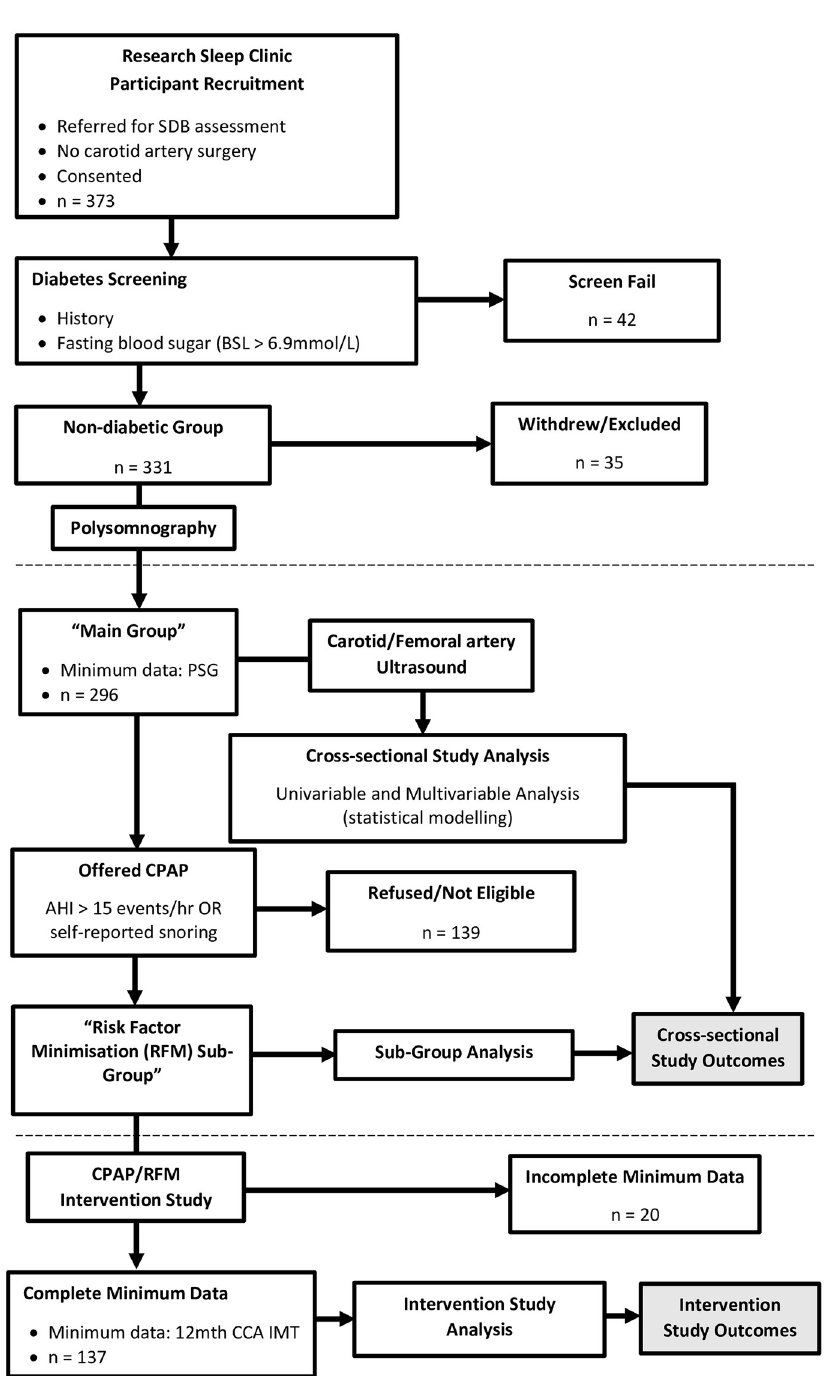
Fig 1. Study flow diagram. Study flow diagram showing movement of participants and data through the recruitment and screening phases, the “Main Group” and “Risk Factor Minimisatation [RFM] Sub-Group” cross-sectional analyses, and the intervention study. SDB = sleep disordered breathing; BSL = blood sugar level; PSG = polysomnography; CPAP = continuous positive airway pressure; AHI = apnea hypopnea index; CCA IMT = common carotid artery intima-media